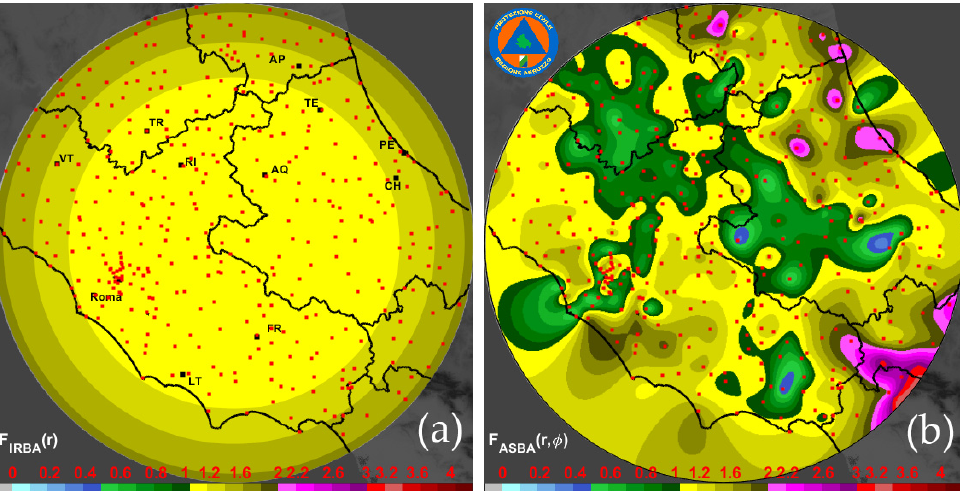
Figure 3. Geospatial correction map applied to the Mt. Midia weather radar, derived from two years of data (2018–2019). ( a ) Isotropic range adjustment (IRBA) method, ( b ) anisotropic spatial adjustment (ASBA) method. Red dots indicate the available rain gauge stations not only in Abruzzo but also for Remote Sens. 2022 , 14 , x FOR PEER REVIEW central Italy regions covered by the Mt. Midia radar range of 120 km.